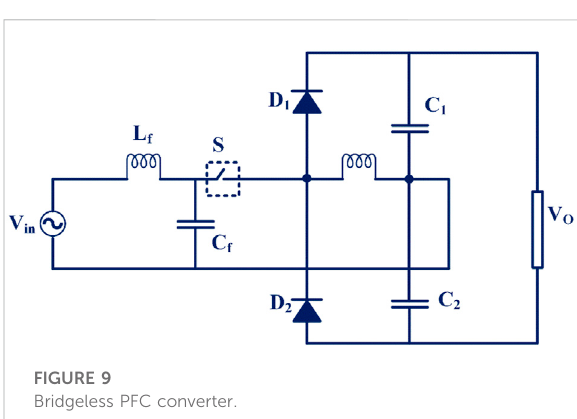
FIGURE 9 Bridgeless PFC converter.